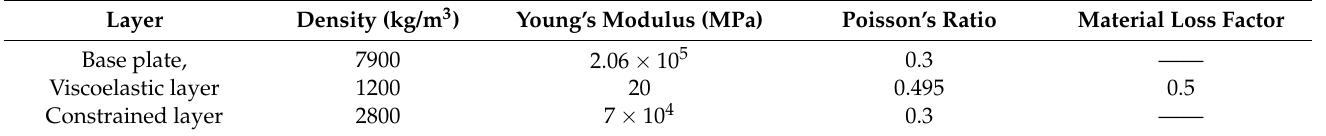
Figure 5. A rectangular plate with four edges clamped. Table 2. Material properties of the plate with constrained layer damping treatment.